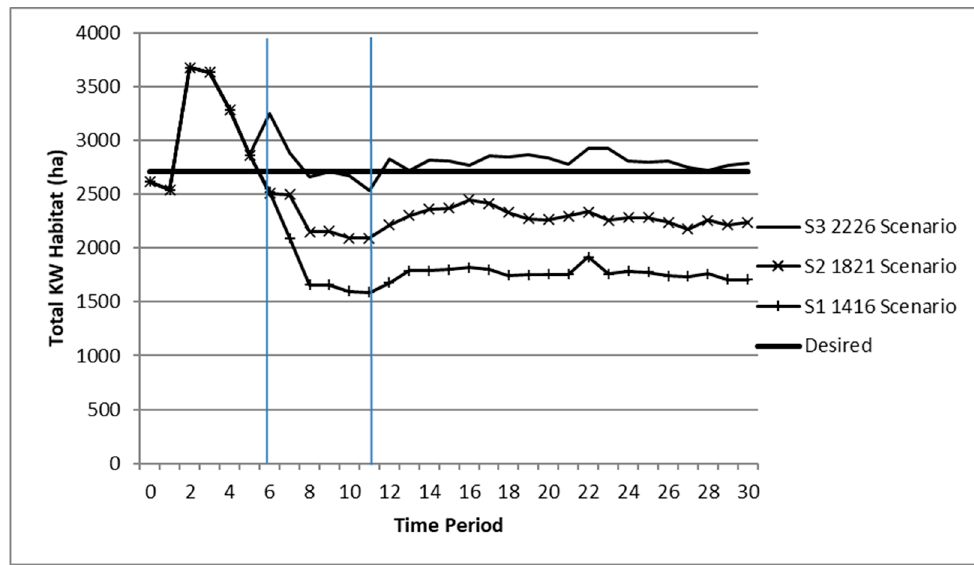
Figure 4 . Total Kirtland’s warbler habitat resulting from constraints on core area. The horizontal line represents 2711 ha of desired habitat as described by the forest plan. Vertical lines at periods 6 and 11 indicate extreme values of the S3 2226 scenario solution.